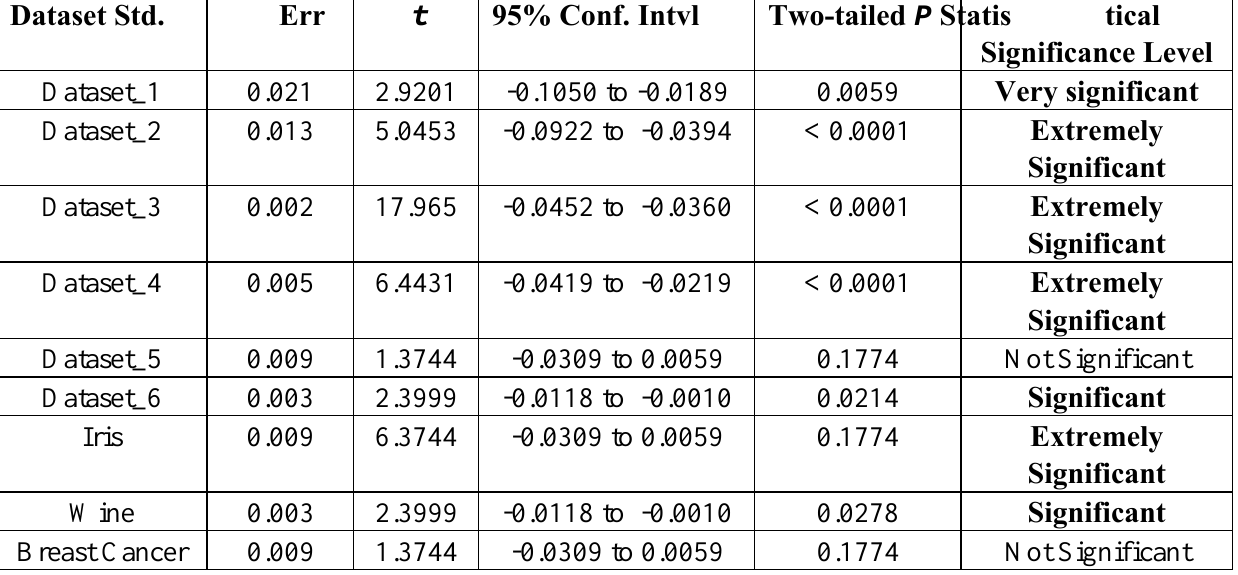
Table 4. Unpaired t- test Results for adjusted Rand index.